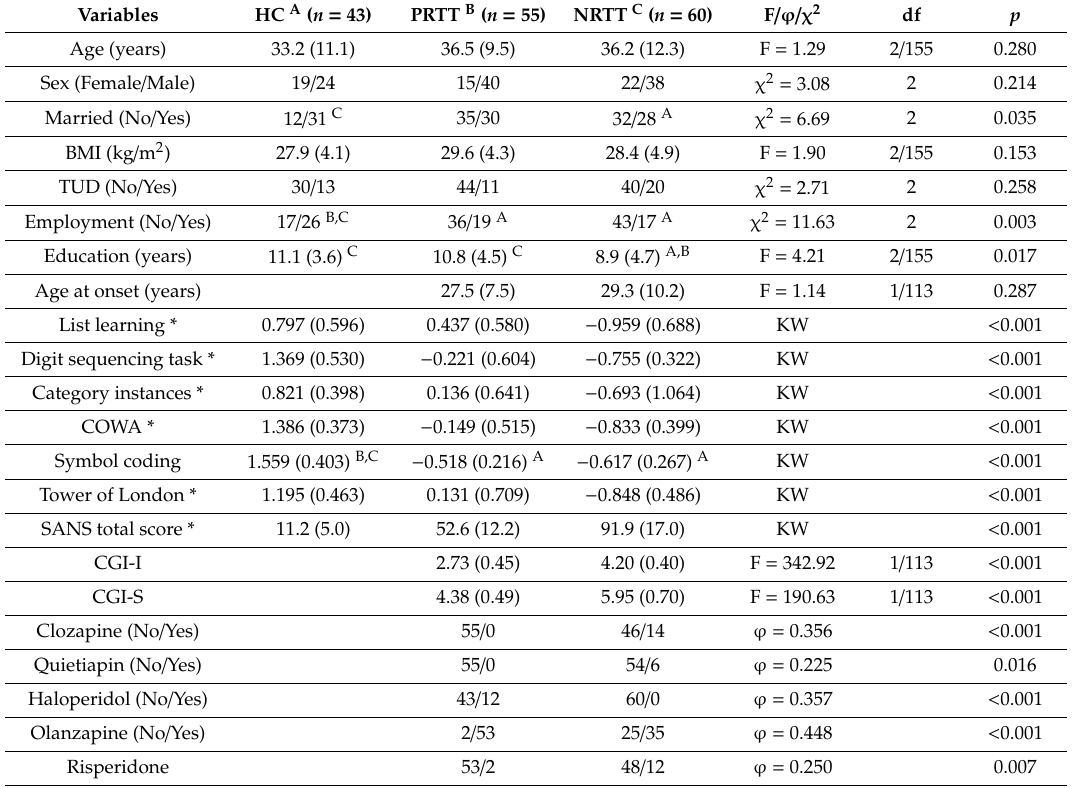
Table 1. Demographic and clinical data of healthy controls (HC) and partial (PRTT) and non (NRTT) responders to treatment.